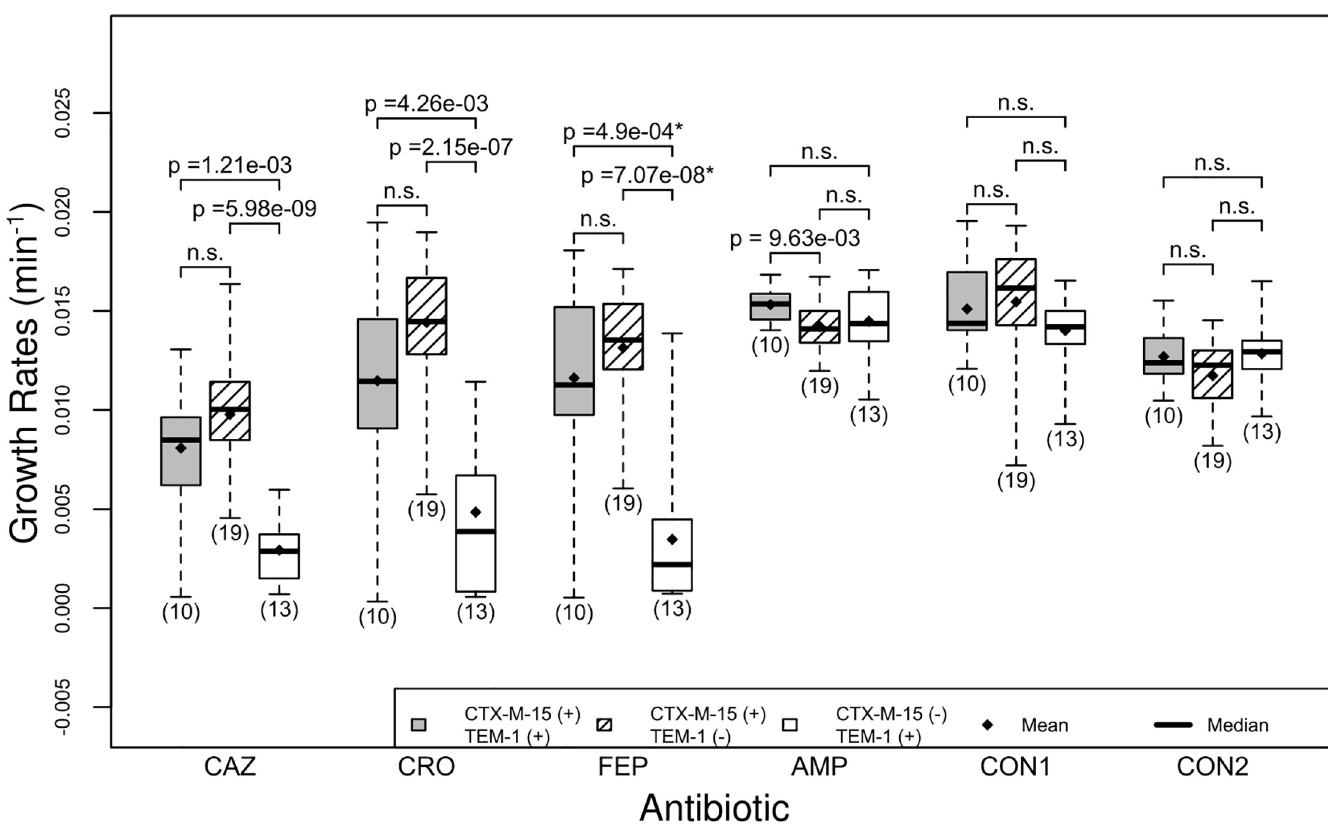
Fig 6. Isolates with CTX-M-15 exhibit higher growth rates irrespective of TEM-1 presence. There are three boxplots per antibiotic, the first boxplot (gray) shows the distribution of growth rates for isolates that have the CTX-M-15 gene and the TEM-1 gene (labeled CTX-M-15 (+) and TEM-1 (+)), the second boxplot (hash marked) shows the distribution of growth rates for isolates that have the CTX-M-15 gene but not the TEM-1 gene (labeled CTX-M-15 (+) and TEM-1 (-)), and the third boxplot (white) shows the distribution of growth rates for isolates that have the TEM-1 gene but not the CTX-M-15 gene (labeled CTX-M-15 (-) and TEM-1 (+)). See Fig 1 for interpretation of